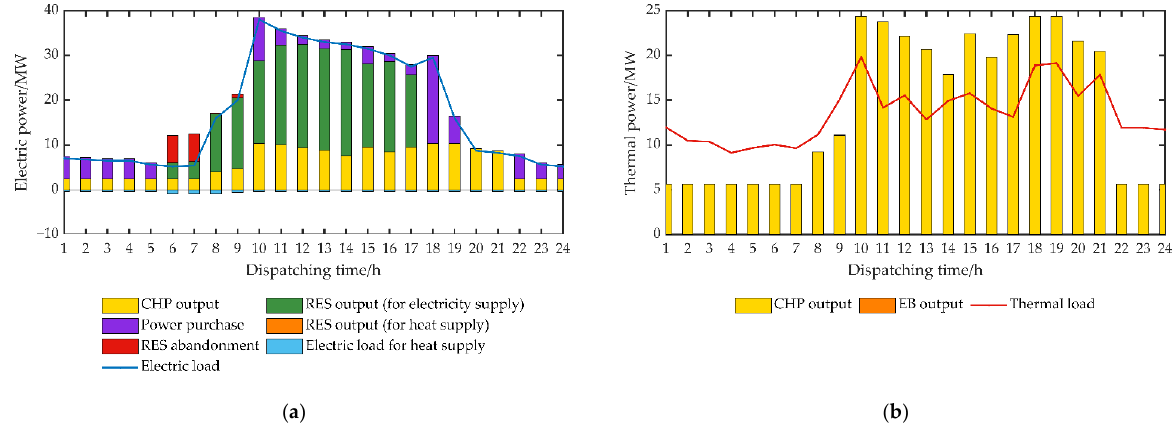
Figure 9. Independent dispatching in the office area: ( a ) Electric power; ( b ) Thermal power.